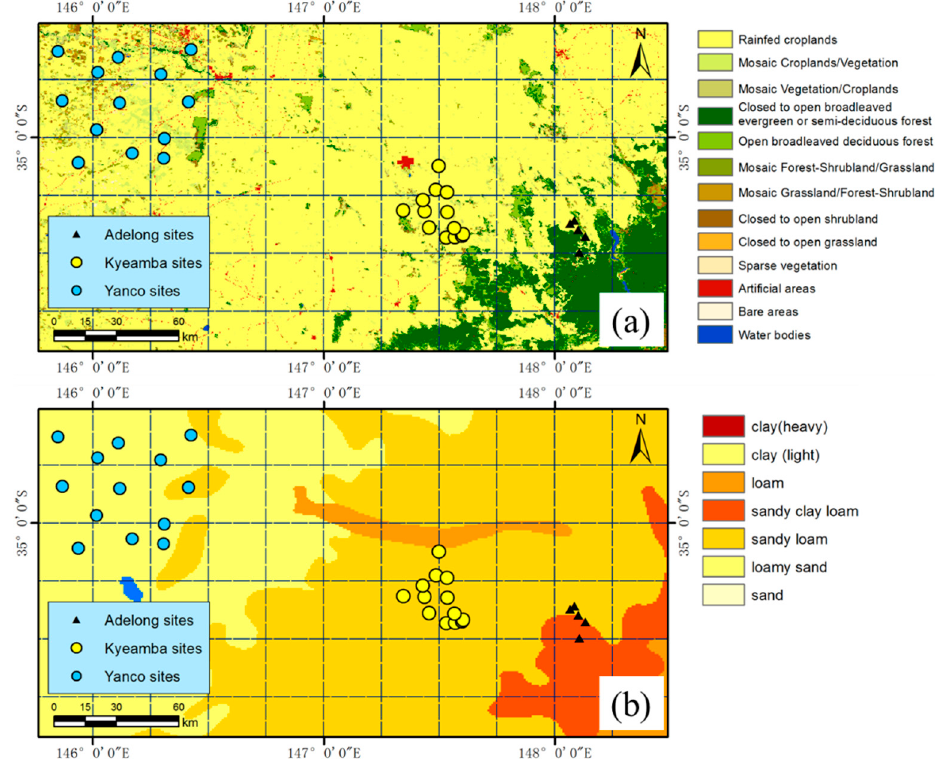
Figure 8. ( a ) Land cover and ( b ) soil texture maps of the study area (the dashed line presents the pixel size of 0.25° × 0.25°).